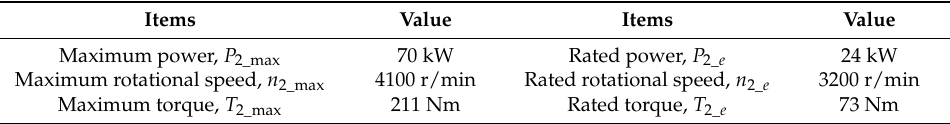
Table 5. Determined parameters of